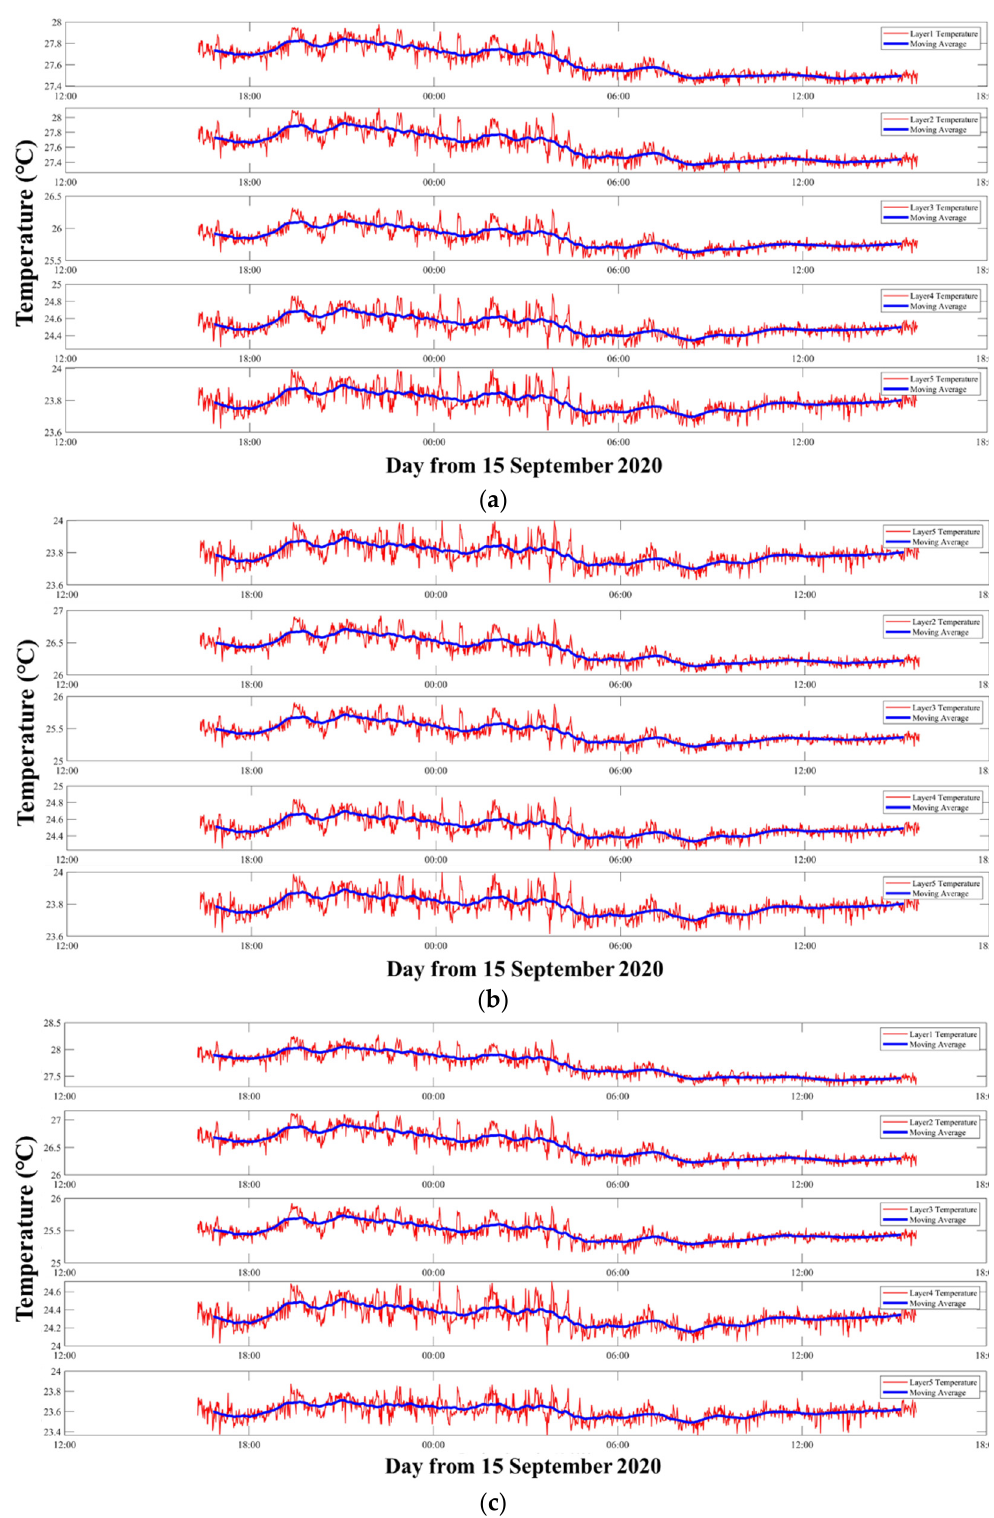
Figure 12. Five layers’ average temperatures along a vertical slice. ( a ) Layer division results of Number 5 ‐ 3. The pvtem ‐ er was samller than 0.8 °C. ( b ) Layer division results of Number 5 ‐ 5. The pvtem ‐ er was smaller than 0.8 °C. ( c ) Layer division results of Number 5 ‐ 5. The pvtem ‐ er was smaller than 0.05 °C.